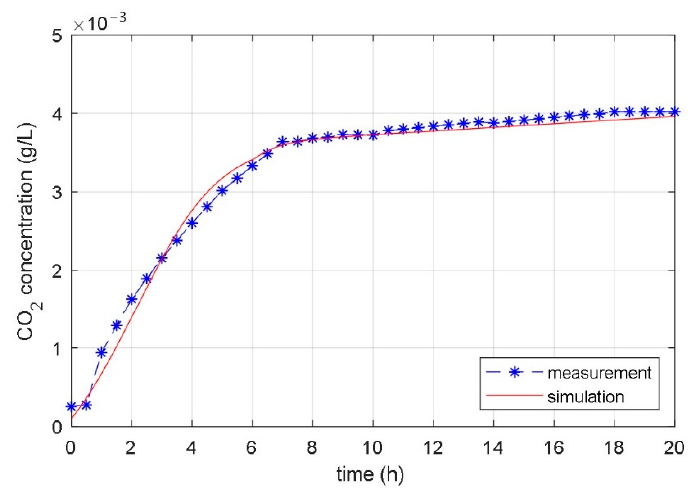
Figure 15. Measured and simulated time courses of the CO 2 concentration during the fermentation process with changeable bioreactor temperature (step change of temperature from 22 °C to 27 °C occurred at time t = 6 h).